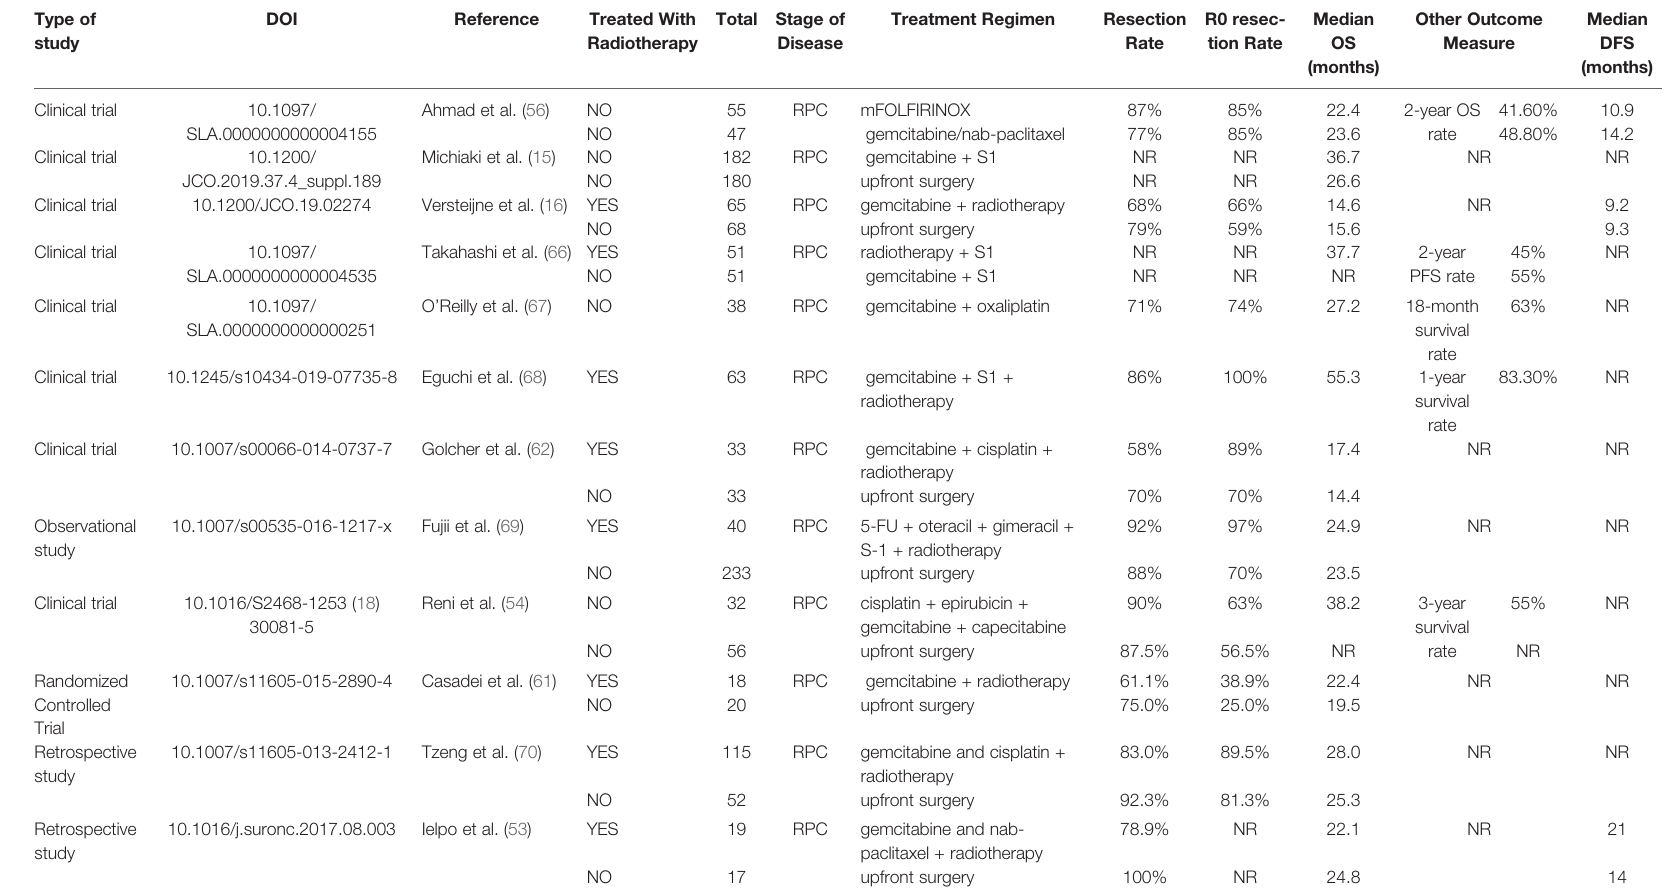
TABLE 3 | Neoadjuvant therapy in